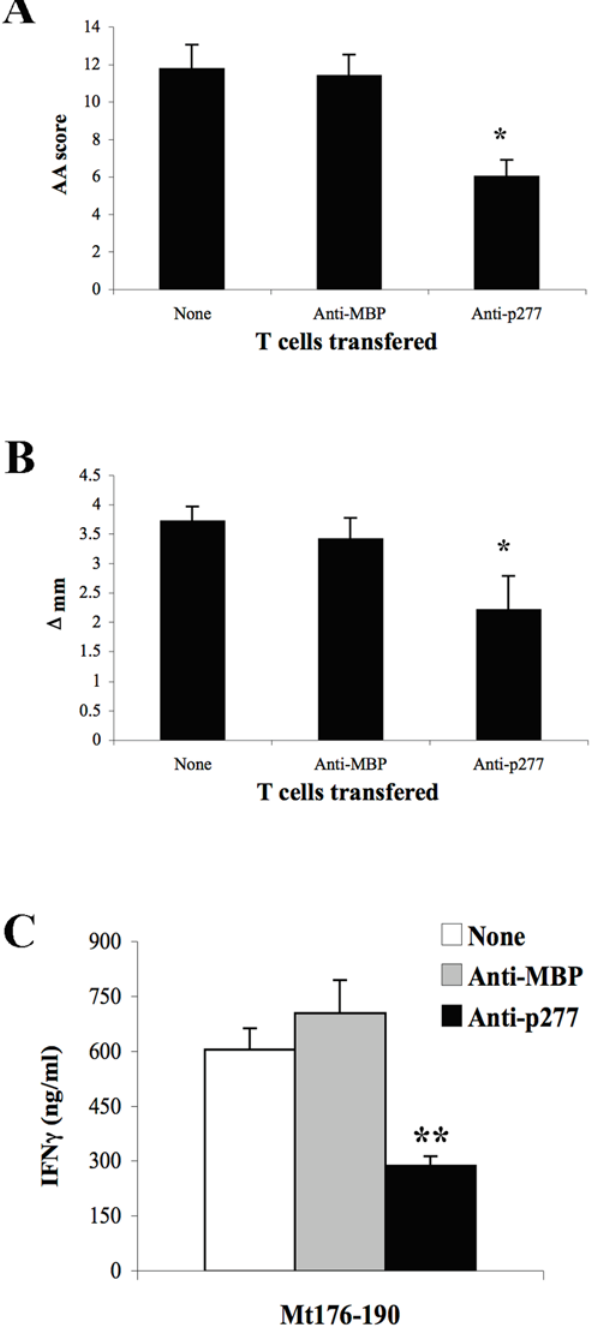
Figure 6. HSP60-specific anti-ergotypic T-cells control arthrito- genic T-cells invivo . A and B. Anti-MBP or Anti-p277 T cells were injected ip into naı¨ve Lewis rats and three days later AA was induced. Twenty-six days after AA induction, at the peak of AA, the AA clinical score (A) and the hind paw diameter (B) were determined. The bars represent the mean values 6 SEM for each group of 8 rats. C. LNC were collected on day 26 after AA induction and the secretion of IFN c upon stimulation with Mt176-90 was studied. The results are presented as pg/